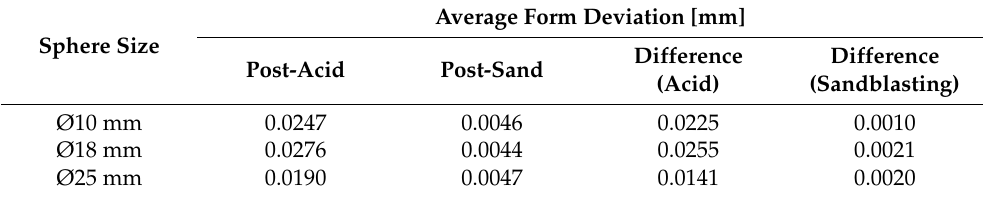
Table 4. Comparison of contact measurement results regarding form deviation pre and post treatments.